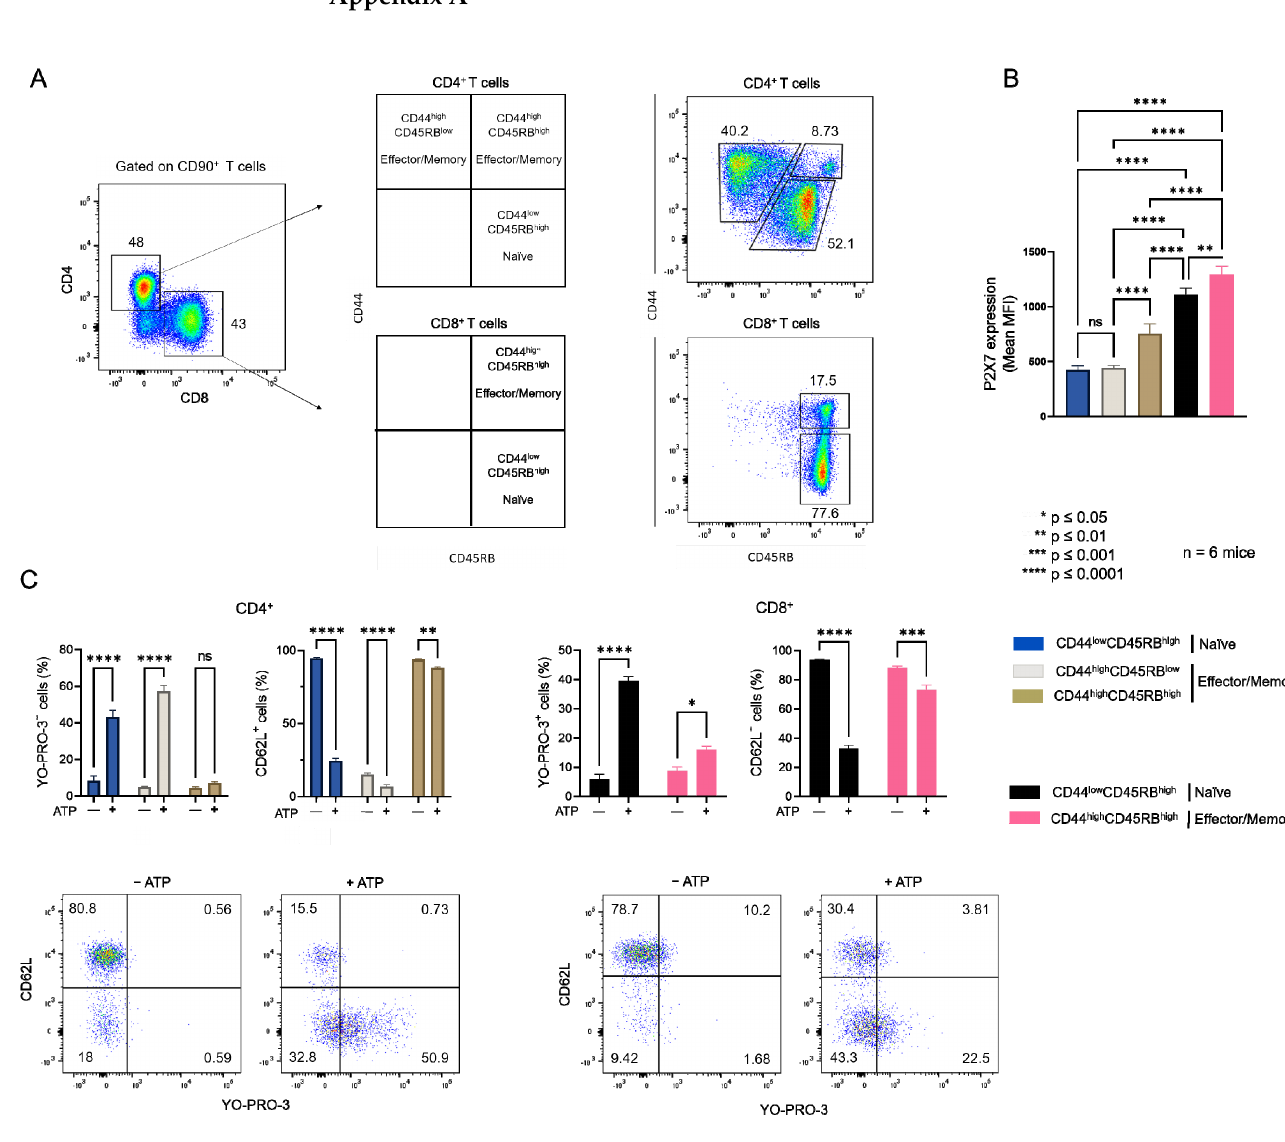
Figure A1. P2X7-mediated cellular responses depend on the differentiation stage of CD4 + and CD8 + T cells. ( A ) Gating strategy for the identification of CD44 low CD45RB high naive and CD44 high CD45RB high or CD44 low CD45RB high effector/memory CD4 + and CD8 + T-cell subsets from mouse spleens. ( B ) Plasma membrane levels of P2X7 was quantified by flow cytometry using BV605-conjugated anti-P2X7 extracellular domain mAb. ( C ) P2X7-dependent pore formation (left panel) and shedding of CD62L (right panel) were evaluated for the various stages of differentiation of CD4 + and CD8 + T cells following stimulation with 500 µM eATP for 30 min at 37 °C. Results are presented as mean histograms and dot plots representative of the experiments. Data are expressed as the mean of percentages (±SEM, n ≥ 6 mice). Asterisks denote statistically significant differences * p ≤ 0.05, ** p ≤ 0.01, *** p ≤ 0.001, **** p ≤ 0.0001, ns: not